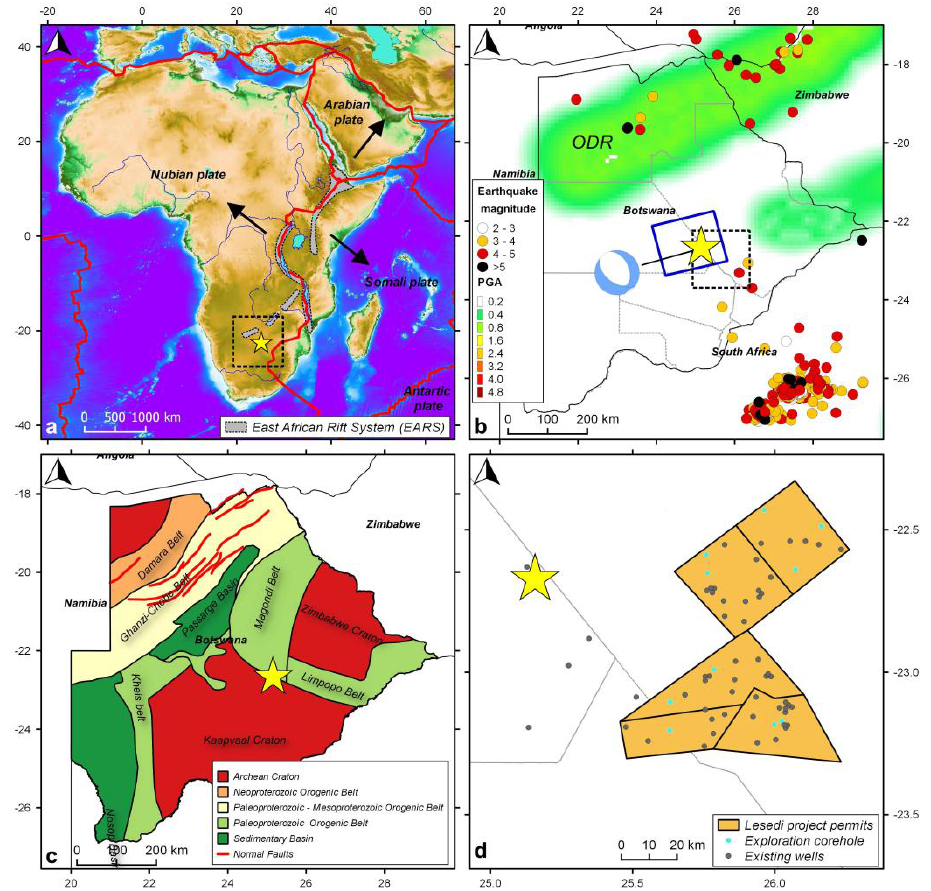
Figure 1. ( a ) Location of the 3 April 2017 , M w 6.5 Botswana earthquake (the yellow star) with respect to the plate boundaries (red lines) and the East African Rift System [11]. ( b ) Detail of the area bordered by the dashed black square in panel ( a ), showing the location of historical earthquakes (https://earthquake.usgs.gov/earthquakes/map/) and the seismic hazard map [5] of Botswana. The earthquakes span from 1950 to 2016. The seismic hazard map shows the Peak Ground Acceleration (PGA) (m/s 2 ) with a 10% exceedance probability in 50 years. The earthquakes in South Africa are caused by mining activities (http://inducedearthquakes.org/). ( c ) Precambrian tectonic map of Botswana outlining the spatial extent of Archean cratons and Proterozoic orogenic belts. Red lines represent the fault system of the Okavango Delta rift zone (modified form Leseane et al. [12]). ( d ) Detail of the area bordered by the dashed black square in panel ( b ), showing the location of the Lesedi project permits (http://tlouenergy.com/lesedi-cbm-project) respect to the 3 April 2017 earthquake. Coordinates are in the wgs84 datum.